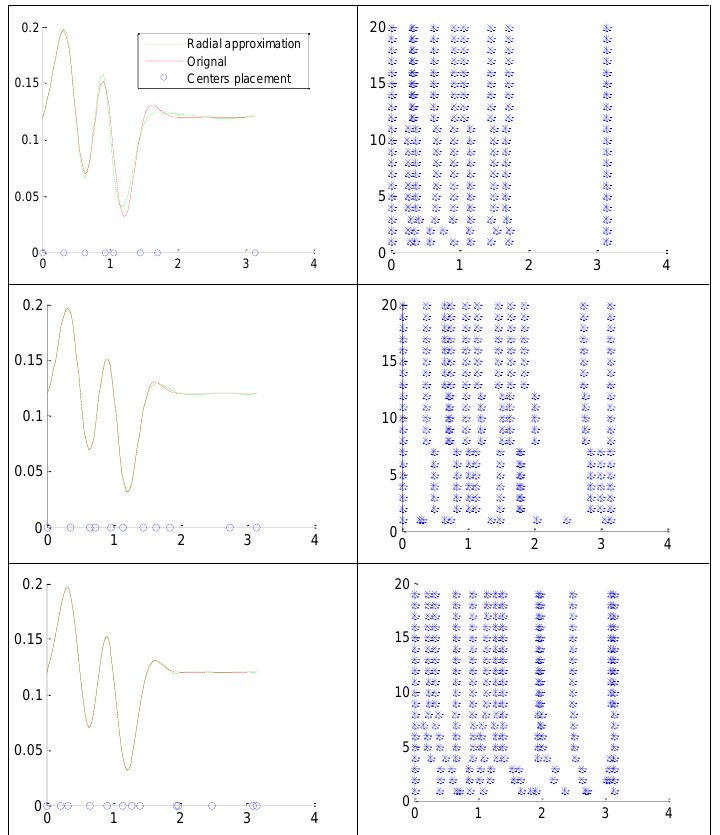
Figure 1. Radial basis approximation and evolution of final centers’ placement for the function f 1 ( x ) with 7, 9 and 11 centers,